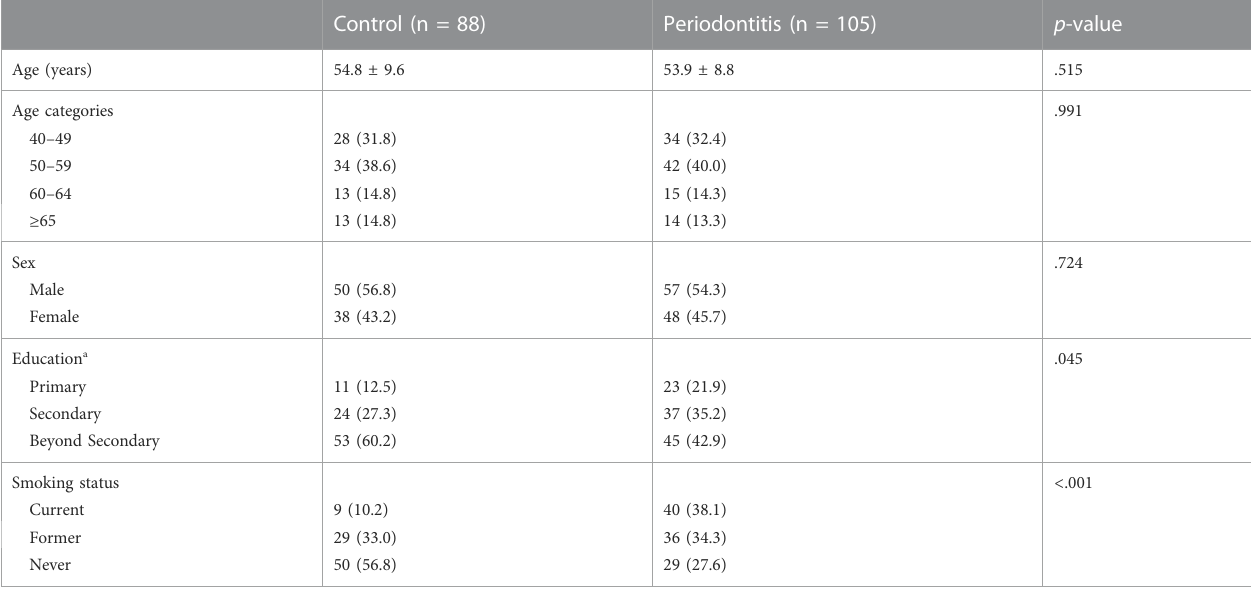
TABLE 1 Demographic characteristics of the study